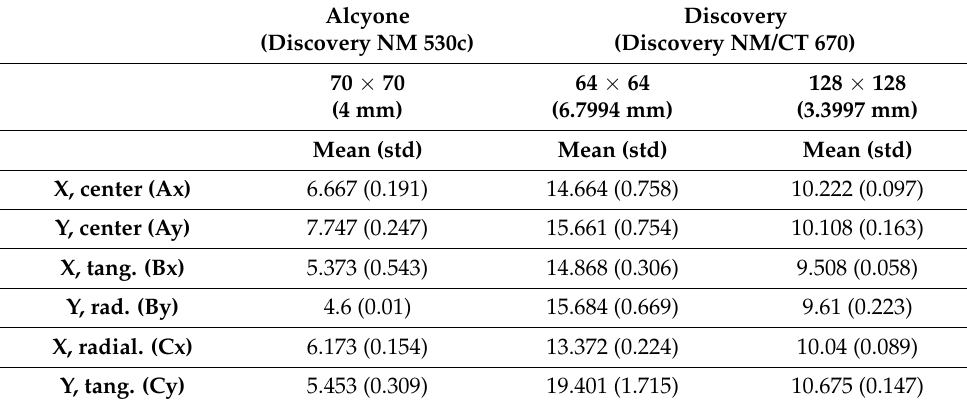
Table 6. Spatial resolution evaluation.